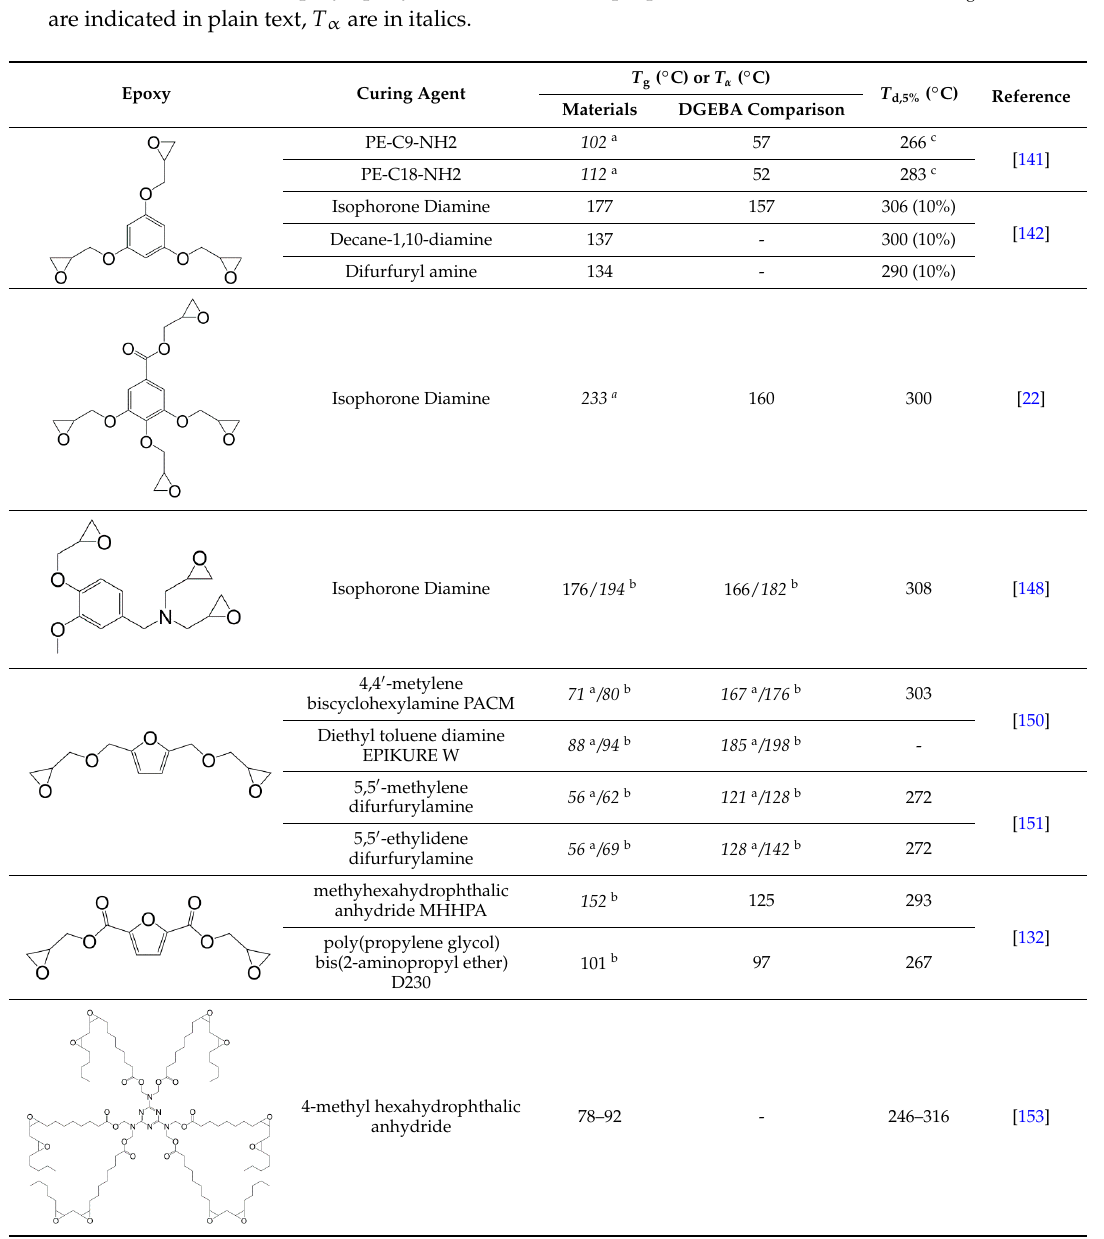
Table 3. Di-epoxy resins with two aromatic rings separated by one atom, and thermal properties of the cured